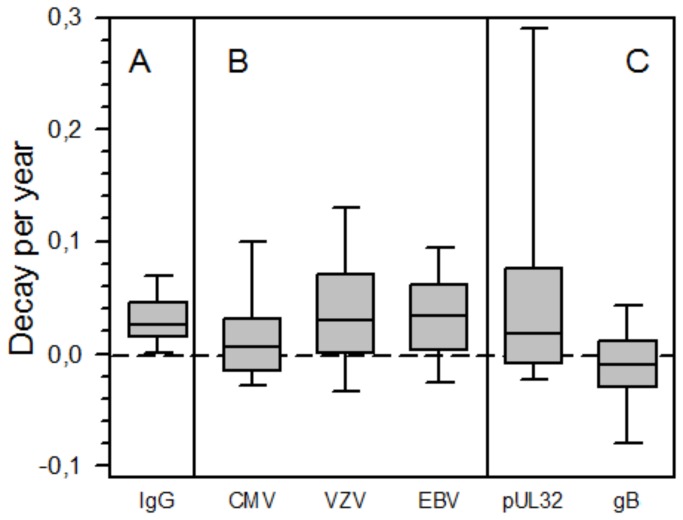
Decay per year of antibody levels in paired samples from CLL patients (n=64).Changes of levels of total IgG and of VZV- and EBV-specific IgG were determined in paired samples of 64 CLL patients. From the same patient cohort, paired samples of the 45 CMV-positive patients were screened for total CMV-specific IgG and IgG specific for the large CMV phosphoprotein pUL32, and for CMV glycoprotein B. Decay was calculated as change in log10 titer per year, positive and negative values indicating decrease and increase in antibody levels over time, respectively. A) Changes of levels of total IgG; B) Changes of CMV-, VZV-, and EBV-specific IgG; C) Changes of pUL32- and gB-specific IgG. Horizontal line indicates constant Ig levels. P-values were 0.034, 0.612, and 0.498 for total IgG vs. CMV-specific, VZV-specific, and EBV-specific IgG. P-values were 0.655 and <0.001 for total IgG vs. pUL32-specific and gB-specific IgG, respectively [Wilcoxon Signed Ranks Test].